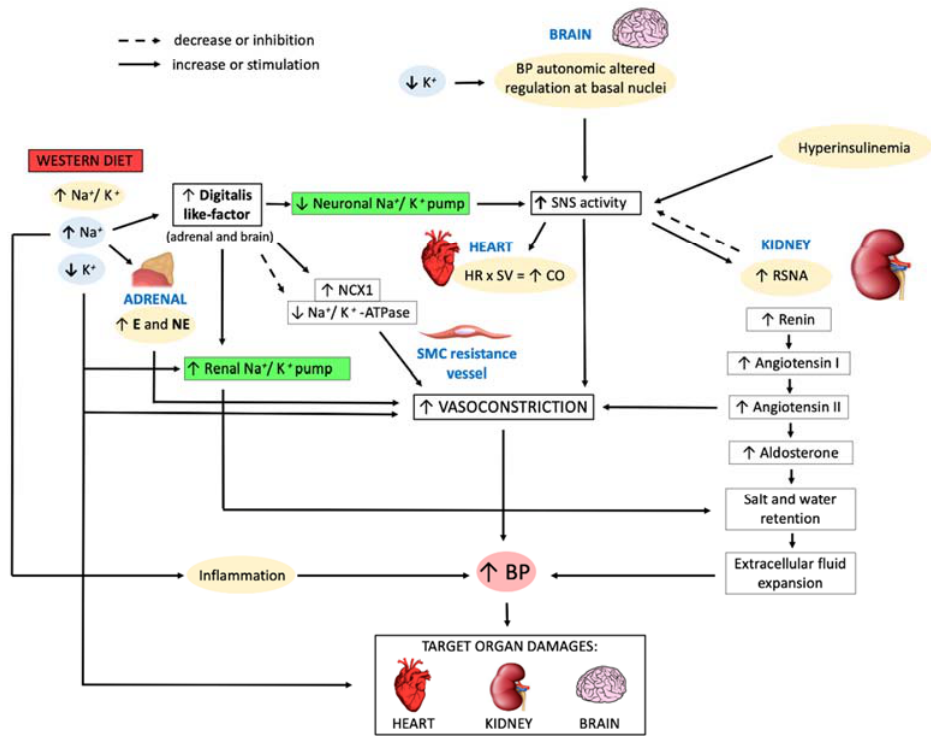
Figure 1. Western diet contribution to pathogenesis of essential arterial hypertension. Abbreviations: BP, blood pressure; CO, cardiac output; E, epinephrine; HR, heart rate; NCX1, sodium-calcium exchanger type 1; NE, norepinephrine; RSNA, renal sympathetic nerve activity; SMC, smooth muscle cell; SNS, sympathetic nervous system; SV, stroke